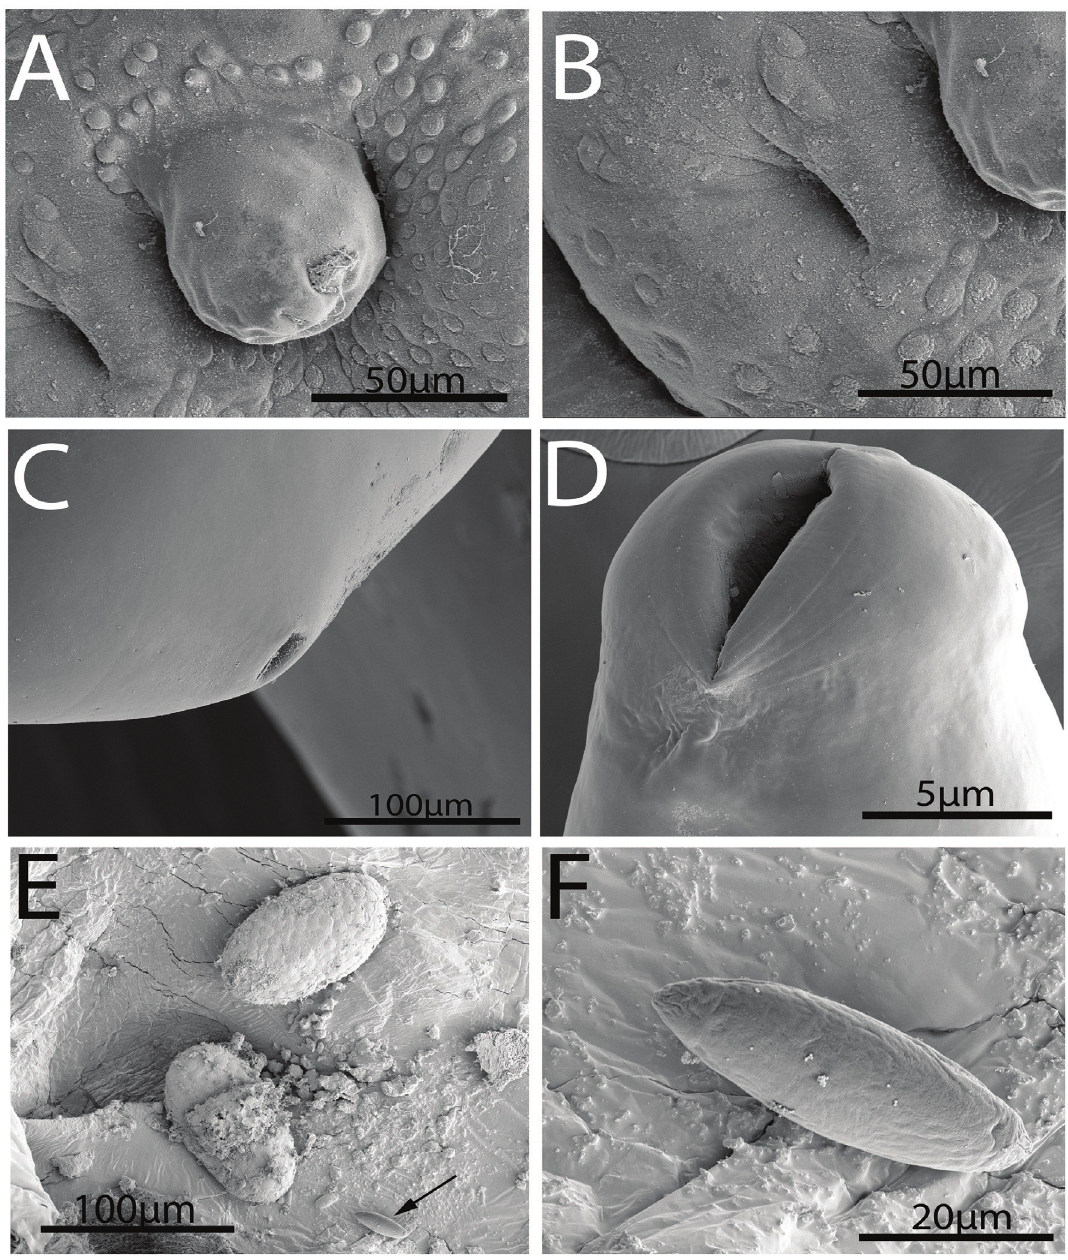
Figure 4. SEM image of specimens of Rhadinorhynchus oligospinosus from Scomber japonicus and Trachurus murphyi from off the Pacific coast of Peru. (A) The terminal genital appendage of a bursa surrounded by inner sensory discs. Note one of the two clefts to left. (B) A larger magnification of one of the two genital clefts with a few sensory discs and part of the terminal genital appendage. (C, D) The various sizes of the female genital orifice are shown with the larger one (D) occupying almost all the trunk diameter at that level; note prominent lips. (E) Two ovarian balls and one mature egg (arrow) from the body cavity of one female specimen. Note comparative sizes. (F) A fully developed egg. Note the lack of any characteristic features or